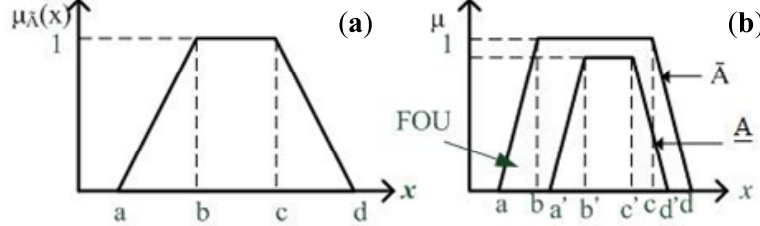
Figure 1. Examples of ( a ) a T1 membership function; ( b ) IT2 membership functions (UMF Ā and LMF 